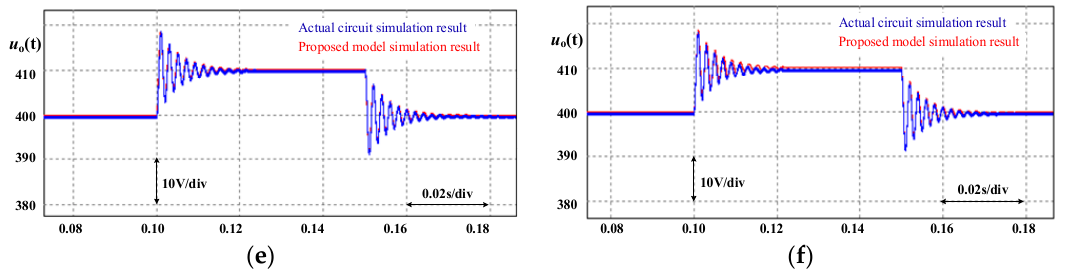
Figure 7. VM number is 2 and ( a ) C na = C nb = 0.67 μ F, duty cycle changes; ( b ) C na = C nb = 0.67 μ F, input